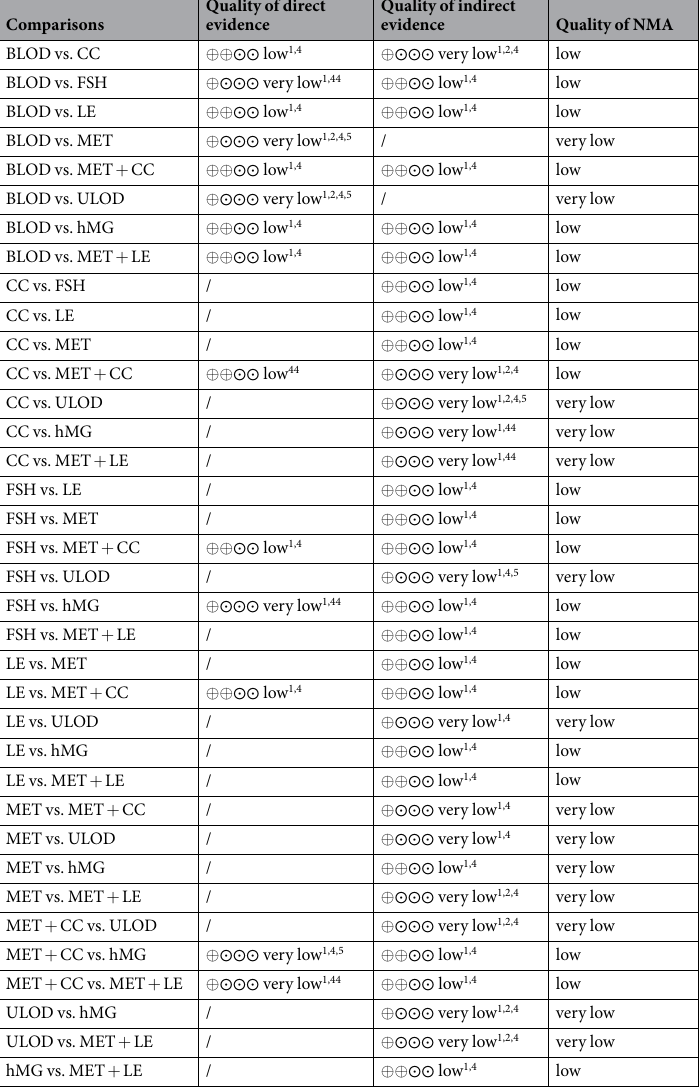
Table 1. Ratings of direct, indirect and network meta-analysis according to the GRADE. CC: clomiphene citrate, MET: metformin, LE: letrozole, FSH: follicle-stimulating hormone, hMG: human